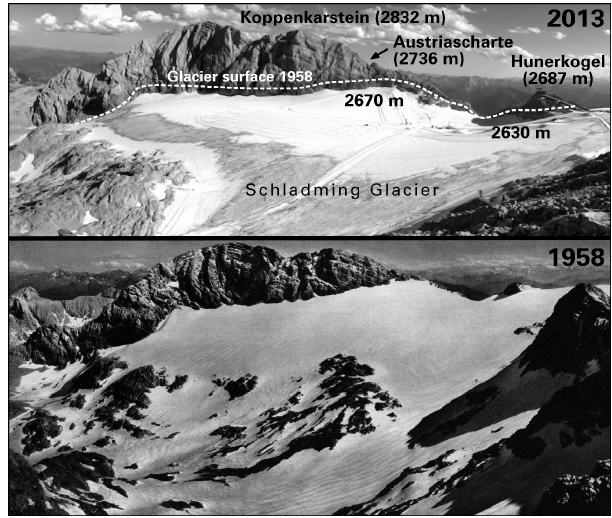
Figure 2. Comparison of the glacier surface at the foot of the Kop- penkarstein in 2013 (photo by Gitschthaler, 2 August 2013) and 1958 (photo by Schneider, July 1958, from Österreichischer Alpen- verein, 1958). Note the obvious surface change at Hunerkogel. Note that the shooting location of both years is not exactly the same.